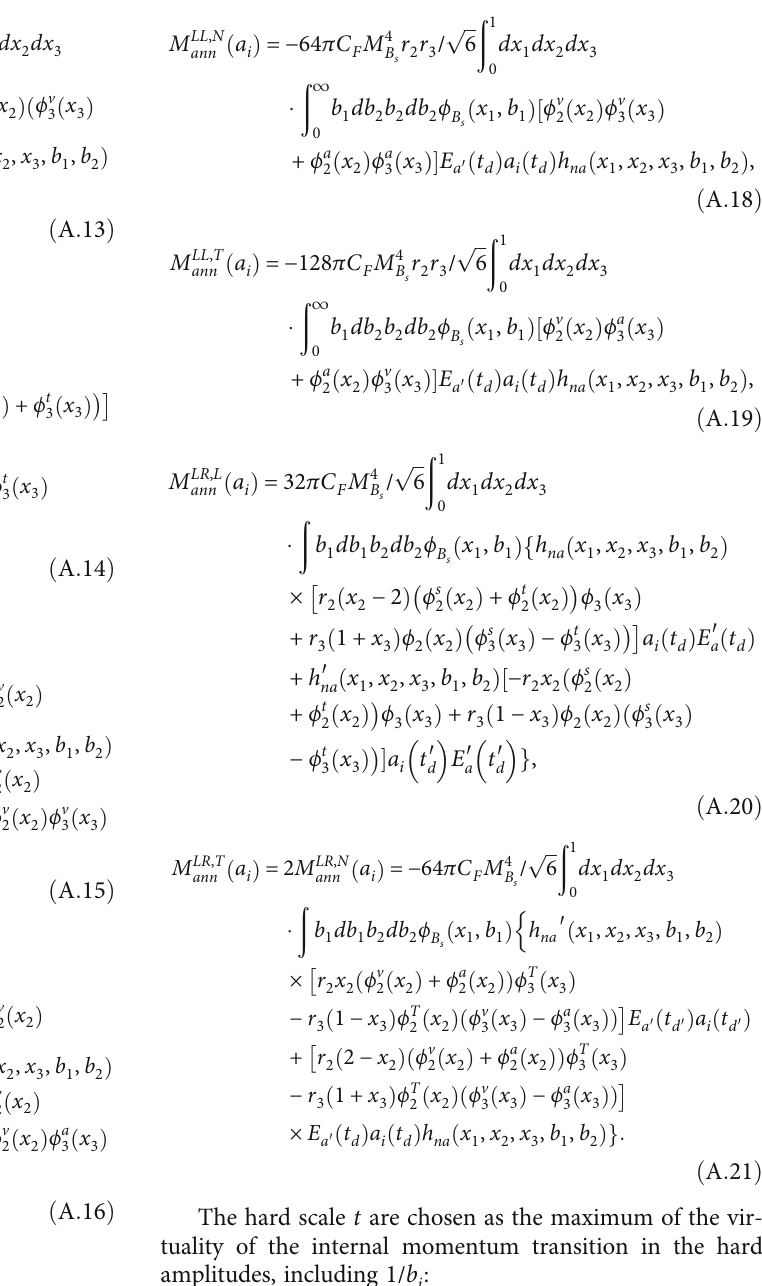
ffiffiffiffiffiffiffiffiffiffiffiffiffiffiffiffiffiffiffiffiffiffiffiffiffiffiffiffiffi ∣ 1 − x